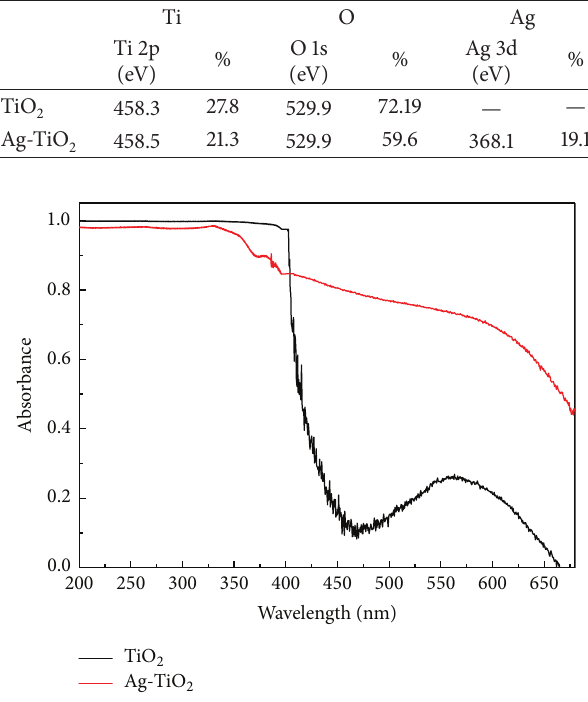
Figure 3: Reflectance spectra recorded for titania and Ag-doped